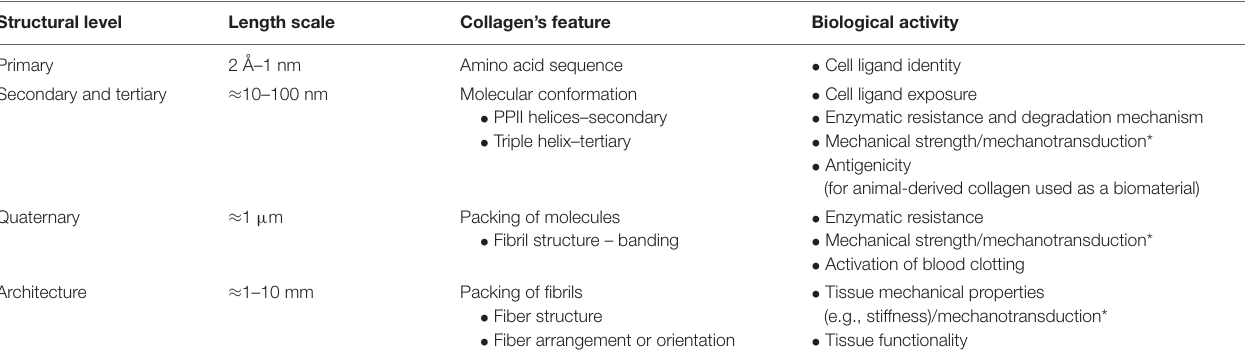
TABLE 2 | Hierarchical structure of fibril-forming collagens: identification of the different structural levels and the related biological activity. Structural level Length scale Collagen’s